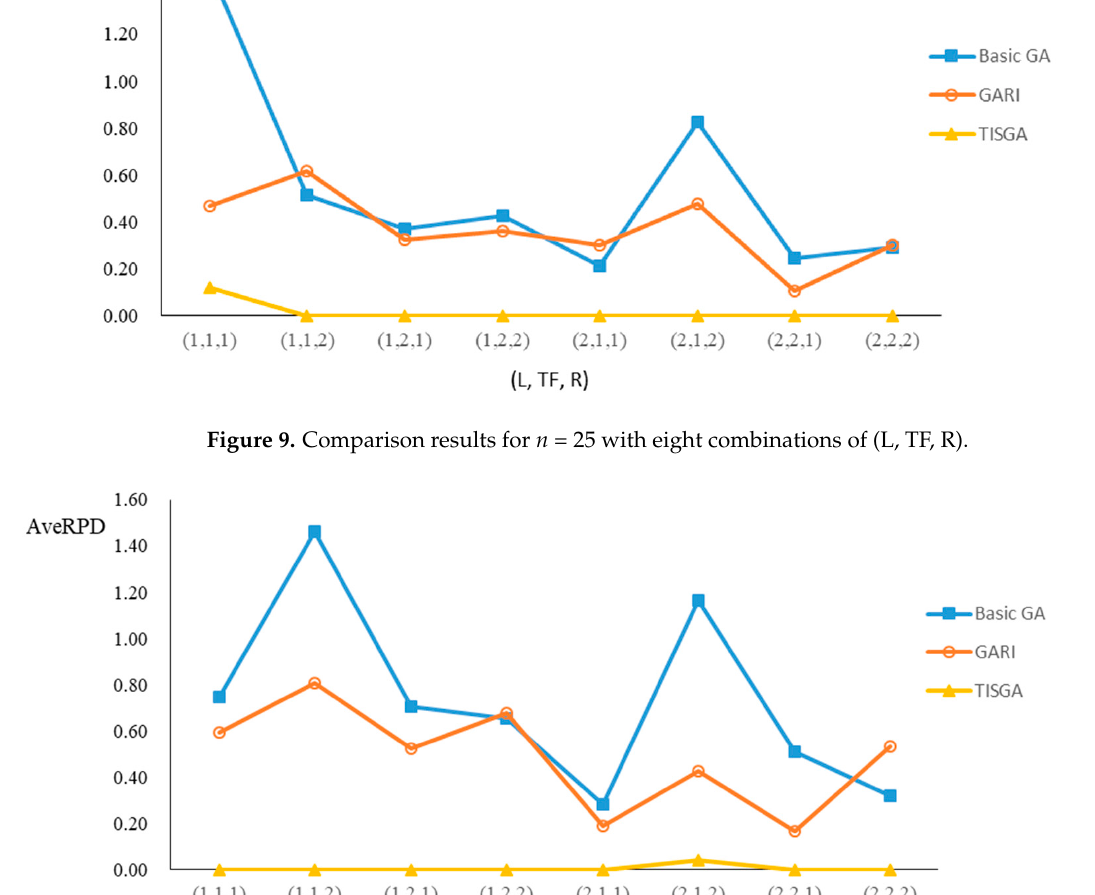
Figure 10. Comparison results for n = 30 with eight combinations of (L, TF, R).